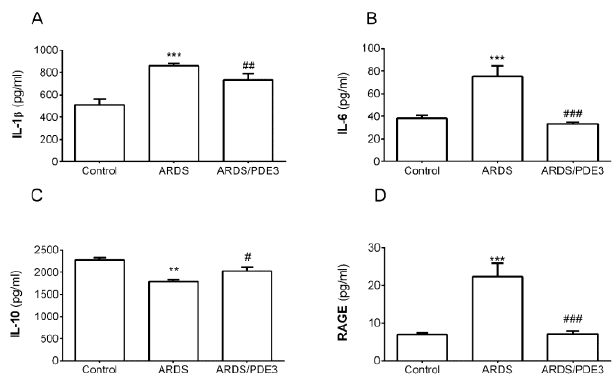
Figure 1. Levels of inflammatory cytokines ( A ) IL-1 β , ( B ) IL-6, ( C ) IL-10, and ( D ) receptor for advanced